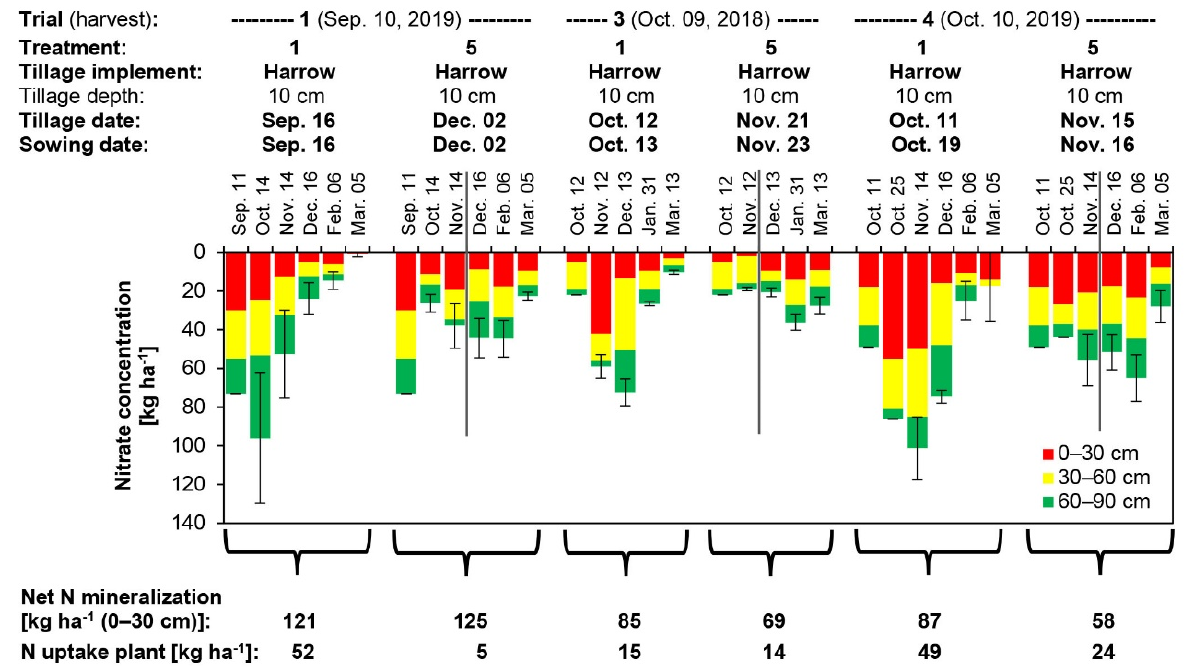
Figure 4. Soil mineral N concentration in the upper soil layers (0–30, 30–60, 60–90 cm) during autumn and winter seasons as well as net N mineralization (0–30 cm) and total N uptake by plants depending on the tillage date after spinach harvest. The gray vertical lines indicate the dates of the postponed tillage ( n = 3; Mean ± SD). n.a. = not applicable.